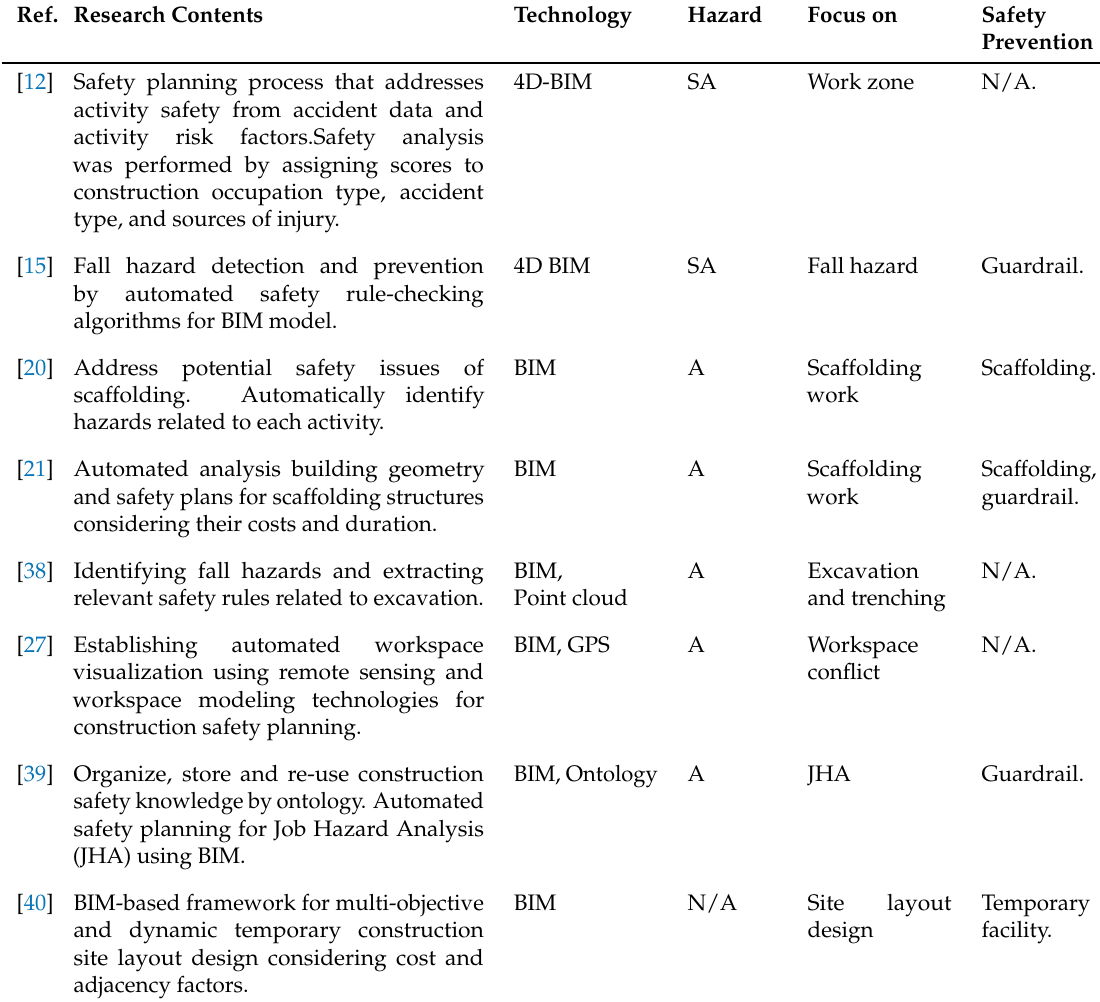
Table 1. Studies on the use of building information modeling (BIM) for safety